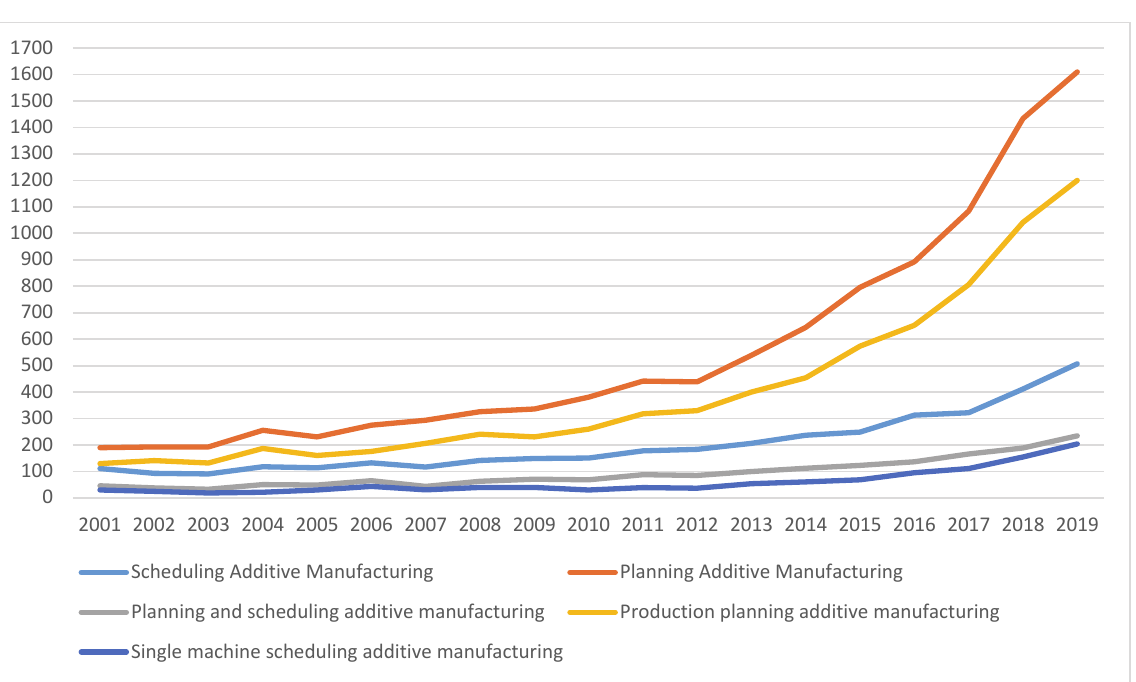
Fig. 1. The growth of interest for the research themes related to the additive manufacturing operations scheduling and